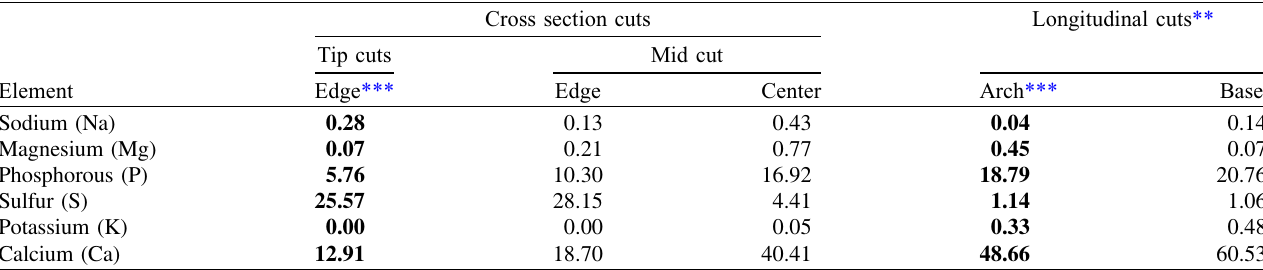
Table 2. Chemical composition of Gallium (LMIS) cut hooks of Heterosentis holospinus .* Cross section